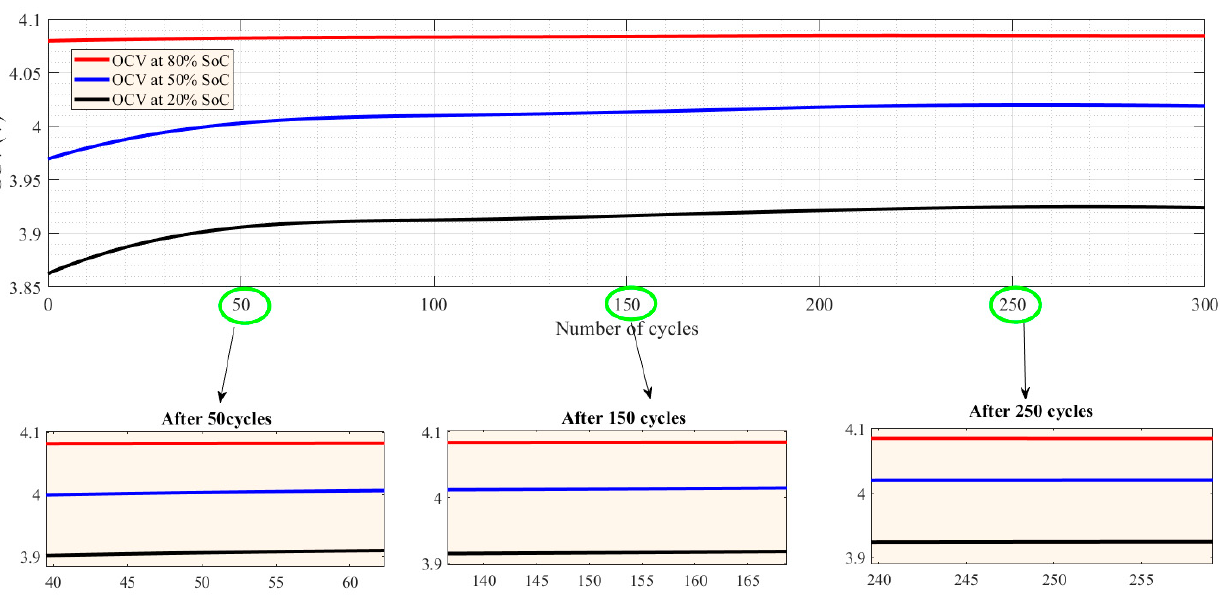
Figure 7. OCV pattern at 10 °C under charge–discharge STPs after 300 cycles during the lifetime of the 3Ah NMC Li-ion battery.